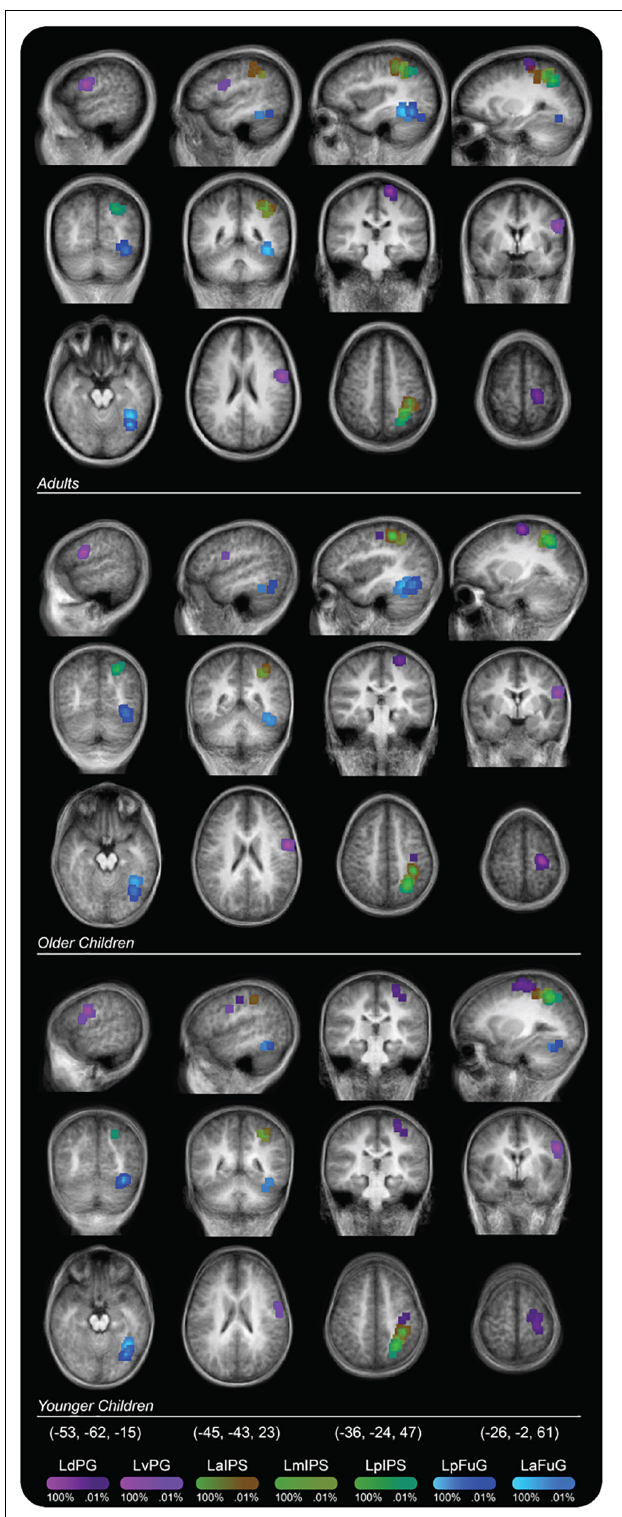
FIGURE 2 | Probability map for regions of interest (ROIs) displayed on a group averaged anatomical image. Percent values correspond to the percentage of participants in a particular group whose ROI placement included that voxel.